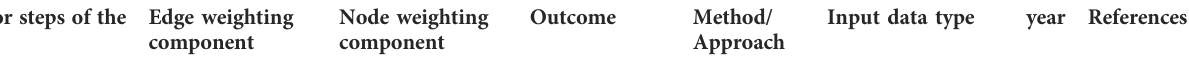
TABLE 1 ( Continued ) Network-based multi-omics integrative tools for predicting biomarkers, crosstalk, disease subtypes, and subnetworks/enriched